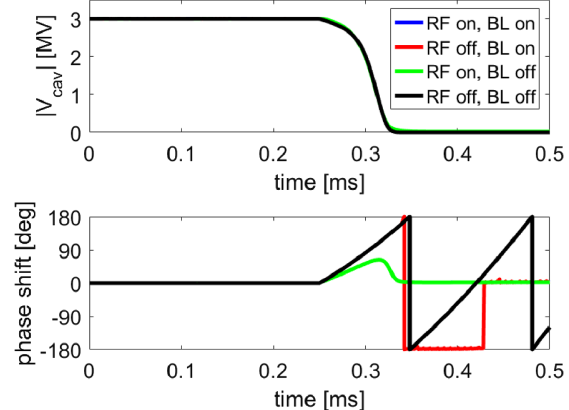
FIG. 10. Plots of cavity voltage amplitude (top) and phase (bottom) for an HL-LHC cavity at 4K during a quench, comparing the effects of the rf system and beam loading.